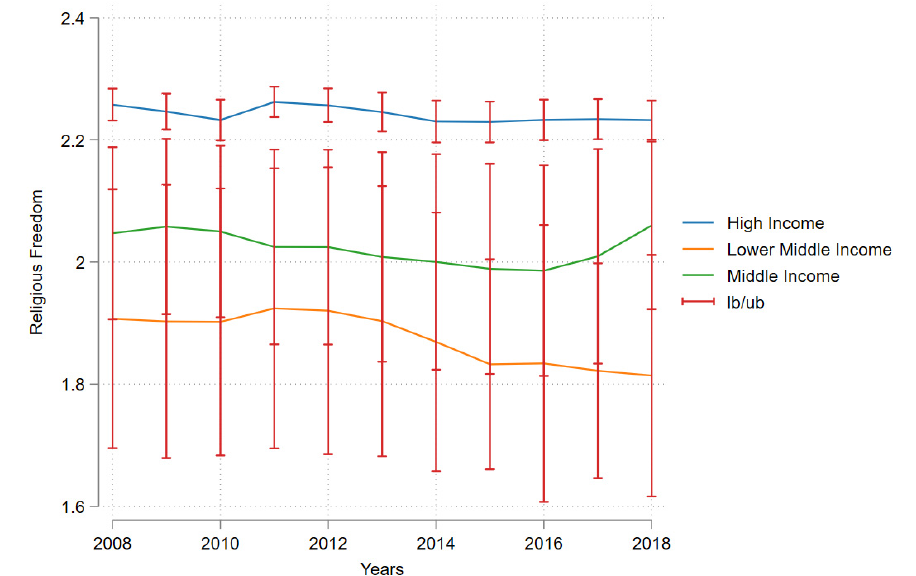
Figure 3. Trends in Religious Freedom by Income Level.